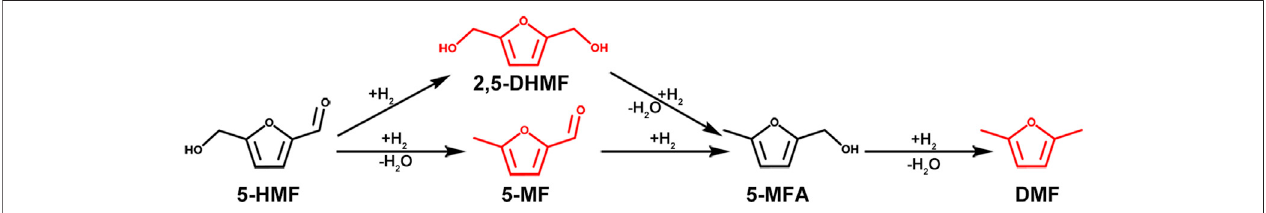
FIGURE 1 | Two reaction pathways for the hydrogenolysis of HMF to